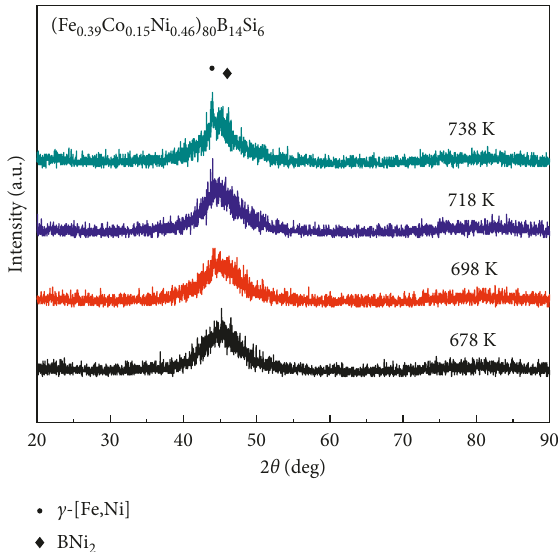
Figure 5: XRD patterns of as-quenched (Fe 0.39 Co 0.15 Ni 0.46 ) 80 B 14 Si 6 ribbons at various annealing temperatures.